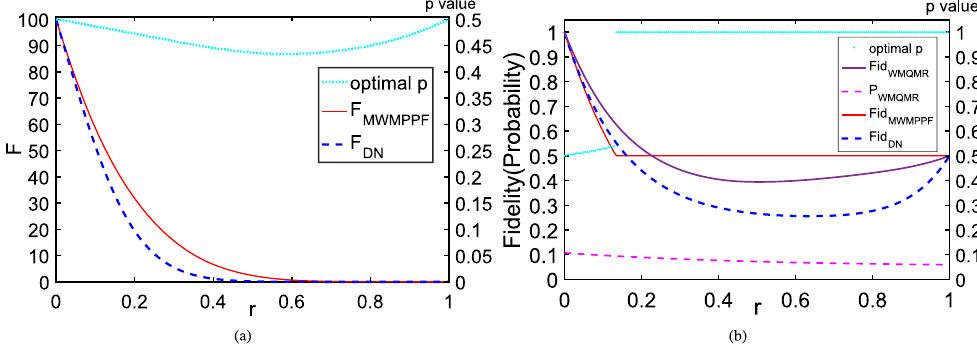
Figure 2. ( a ) Average QFI and its optimal p vs. r with N = 10, θ = π /2. (1) F MWMPPF (red full line) is the maximal average QFI of WMPPF: F WMPPF by choosing the optimal p value as r varies; (2) the optimal p value (celeste dotted line) for F MWMPPF according to r can be drawn at the same parameters with the coordinate scale on the right edge of the figure; (3) F DN (blue dashed line) for DN case. ( b ) Average fidelity and its optimal p and probability vs. r with N = 10, θ = π /2. (1) Fid MWMPPF (asterisk line): the maximal average fidelity of WMPPF; (2) the optimal p value (celeste dotted line) for Fid MWMPPF can be drawn at the same parameters with the coordinate scale on the right edge of the figure; (3) Fid MWQMR (purple full line), we provide its p 1 = p r = 0.2 as an example and its probability is: (4) P WMQMR (magenta dashed line) with the same parameters; (5) Fid DN (blue dashed line).